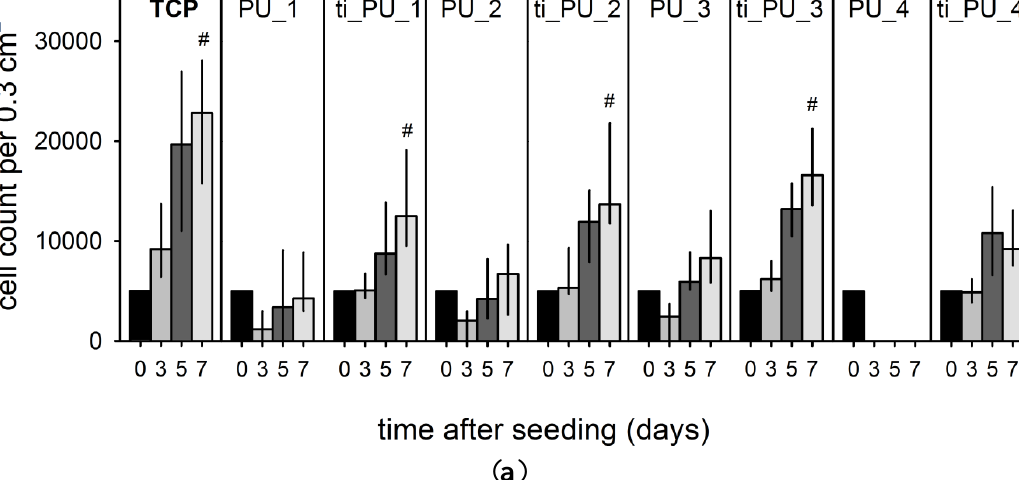
Figure 3. An in vitro study ( n = 16) over seven days regarding proliferation of human endothelial cells seeded onto different PUs. ( a ) Cells were seeded (5000 cells per 0.3 cm 2 ) onto test samples made of PEU (PU_1, PU_2, PU_3) and PCU (PU_4) without and with titaniferous upgrading (ti_PU) and tissue-cultured polystyrole (TCP). Cell counts were analyzed on day 3, 5 and 7 after seeding. Data are presented as median (25/75th percentile). Statistical analysis included increase in cell count from day 3–7 (#, p ≤ 0.001). Cell count on day 7 was highest for TCP and significantly lower for ti_PU_1 ( p = 0.002), ti_PU_2 ( p = 0.015), ti_PU_3 ( p = 0.056); ( b ) on day 7 after seeding cells formed a confluent monolayer onto PEUs. One representative sample presented CD31-FITC stained EC.